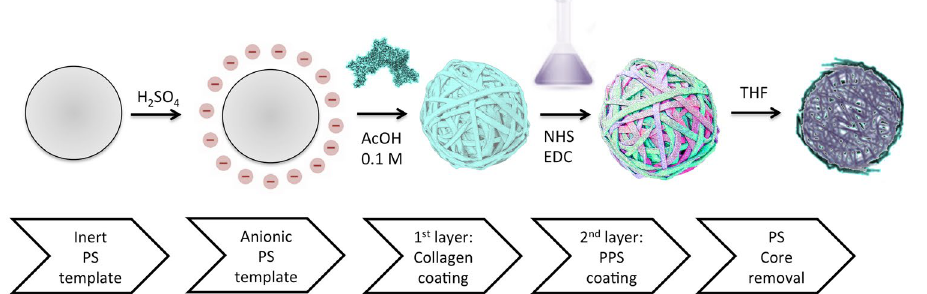
Figure 8. Step-by-step graphical representation of ROS-responsive hollow spheres fabrication